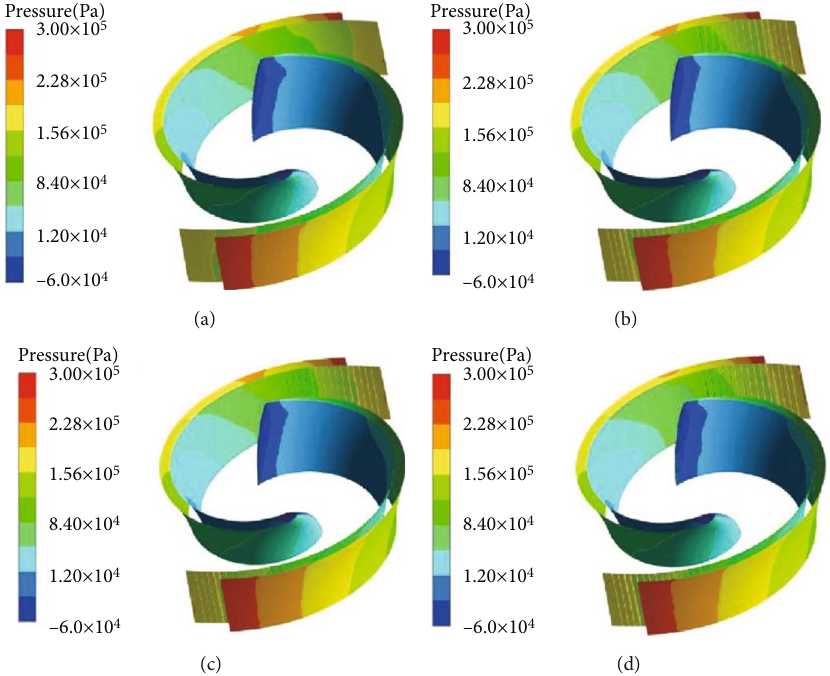
Figure 8: Cloud plot of pressure distribution of vanes at ρ = 0kg/m 3 .